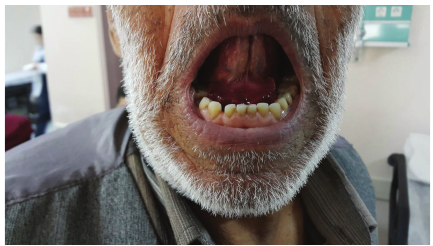
Figure 1: Sublingual hematoma.